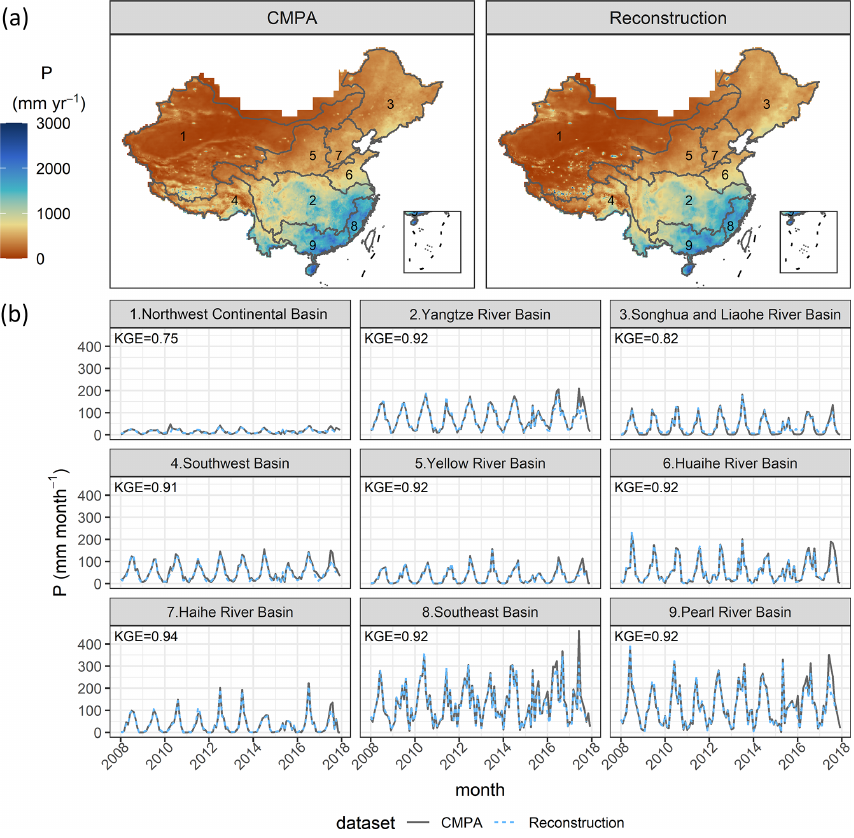
Figure 6. (a) Map of the annual average precipitation ( P ) of the CMPA and reconstruction in 2008–2017. (b) Time series of the monthly P of the CMPA and reconstruction for nine major river basins in 2008–2017. Note that the CMPA has missing values in 2015; we only choose the days when the CMPA has available data in the temporal aggregation for both the CMPA and reconstruction. Here the reconstructed P data are out-of-bag predictions in the cross-validation.